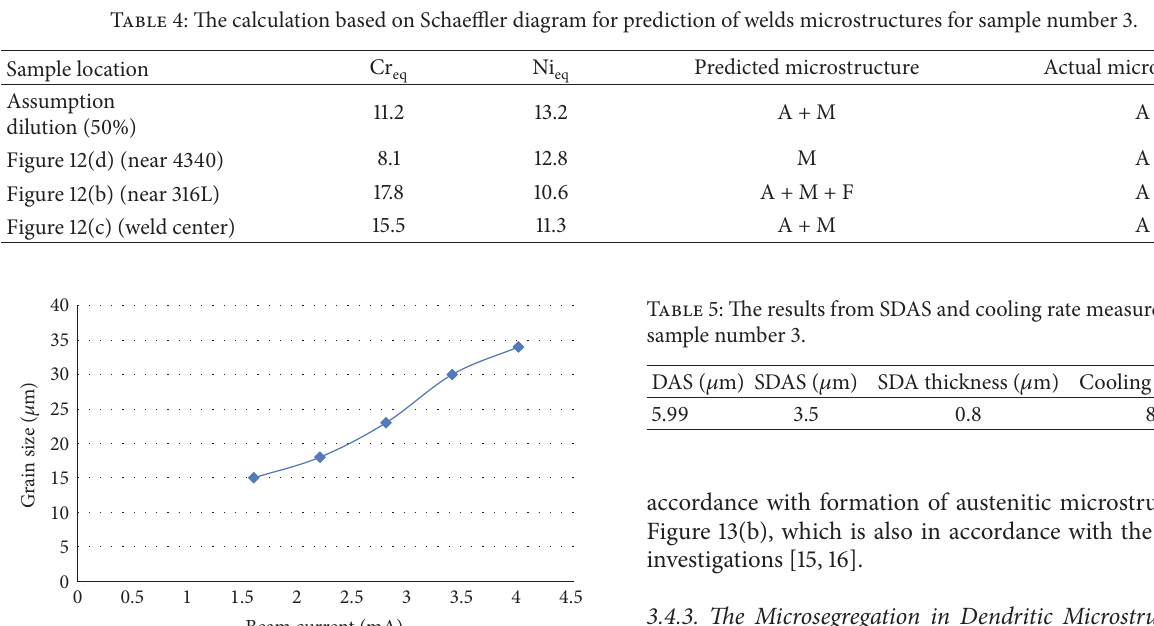
austenite dendrite tip temperature is higher than ferrite and this attributed to change solidification mode from austenite + martensite to fully austenite. High cooling rate effect is in